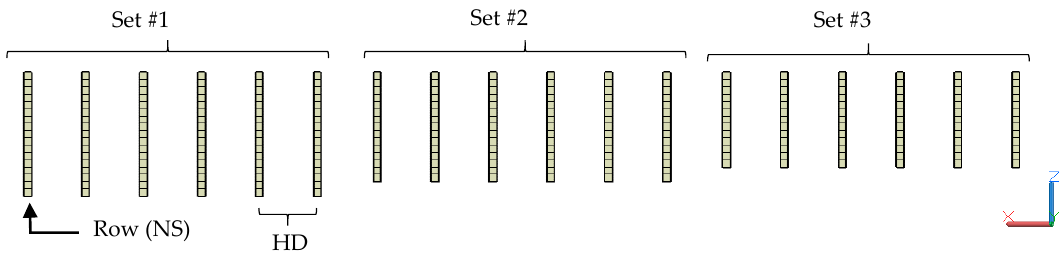
Figure 5. Definition of the various parameters in the arrangements of sleepers in the horizontal direction: Sets, HD, and row determination.